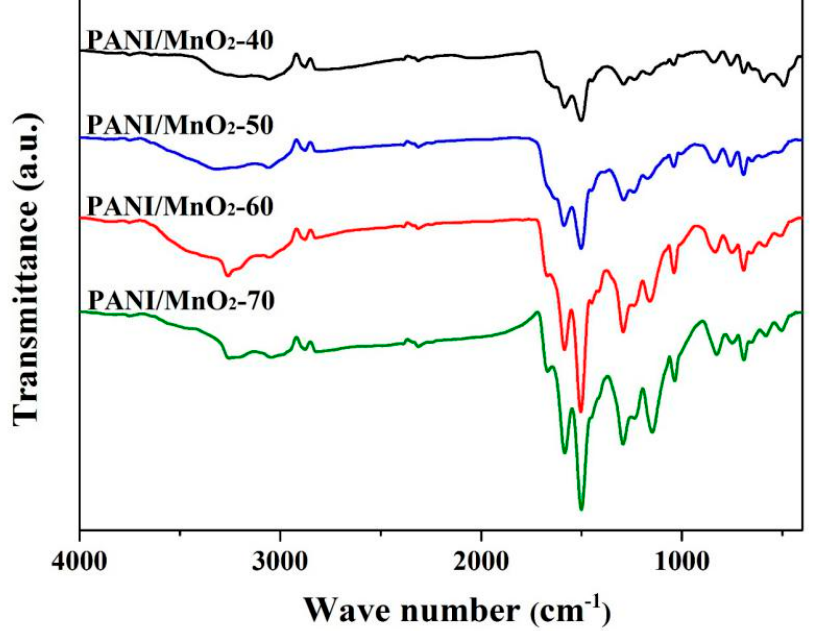
Figure 4. FTIR spectra of PANI/MnO 2 composites.